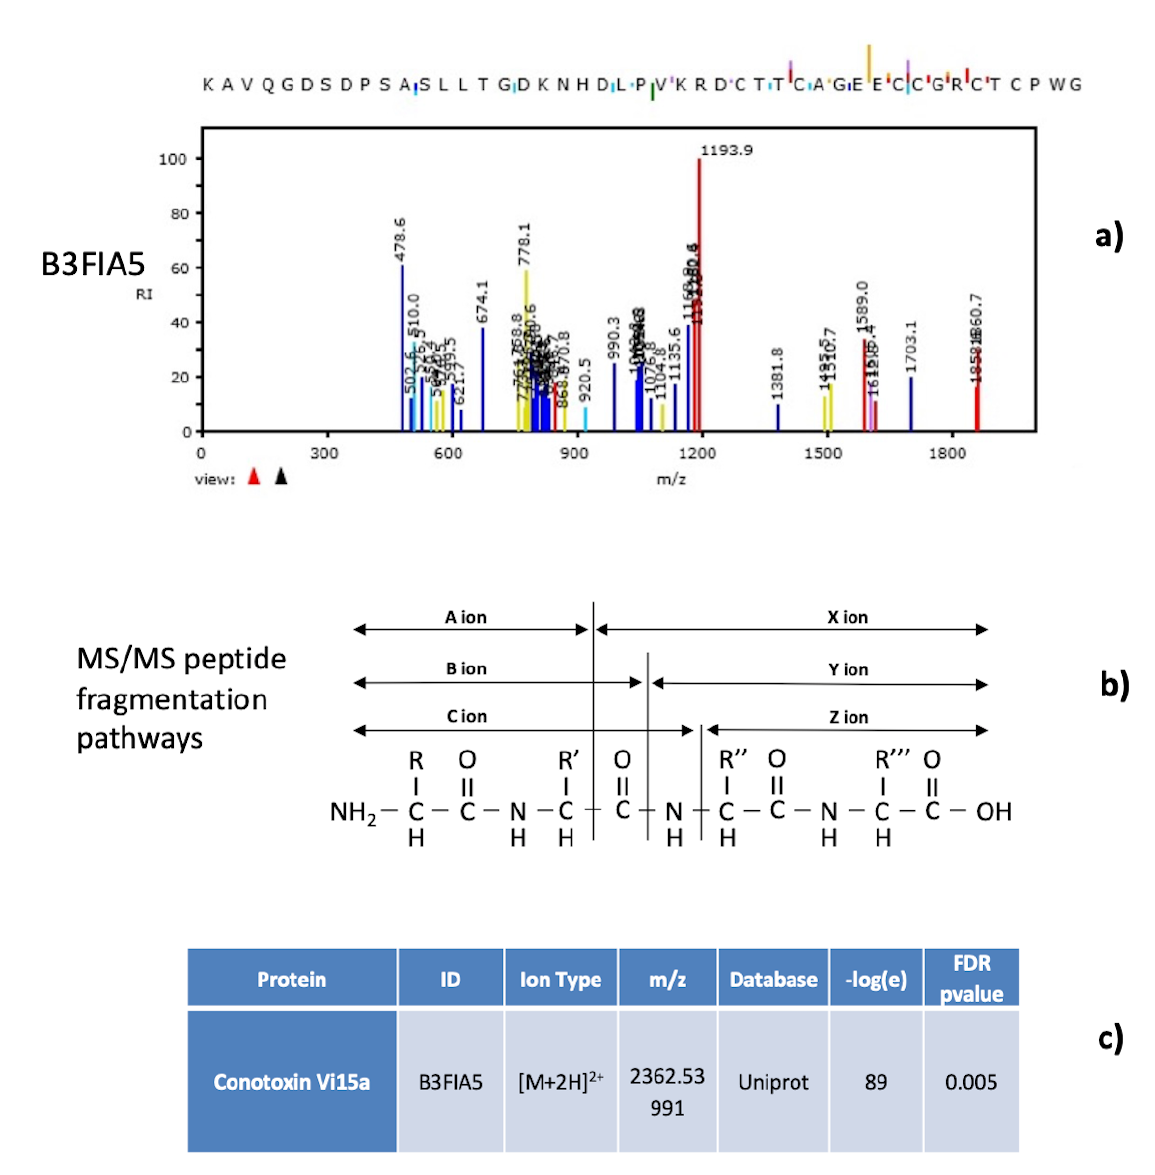
Figure 3. Examples of mass spectra peptide characterization together with the peptide ion fragmentation pathways. Example of how MS/MS signal were assigned to the different N-terminal y,z (blue and purple colour in panel a ) and c-terminal b,c (red and yellow colour) fragmentation series (detailed in panel b ). Only mass spectra exhibiting a statistical -log(e) score higher that 10 and a false discovery rate lower than 0.05 were considered for the identification (reported in panel c ). False discovery rate and statistical score were estimated by means of reverse sequence